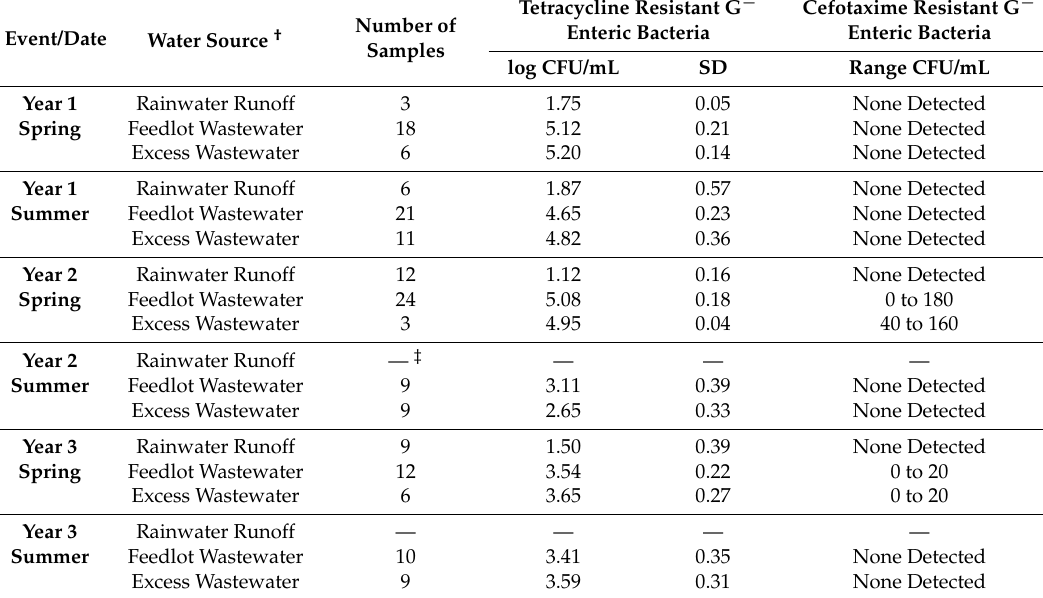
Table 1. Abundance of antibiotic resistant * enteric microorganisms in wastewater samples collected from the vegetative treatment system.